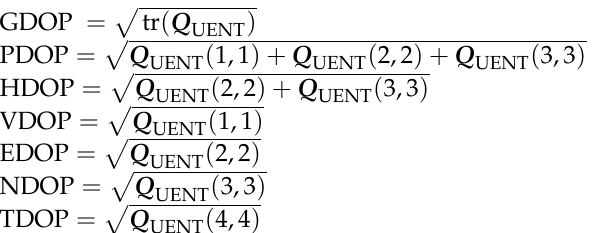
κ of the observation probabilities of MEO satellites.